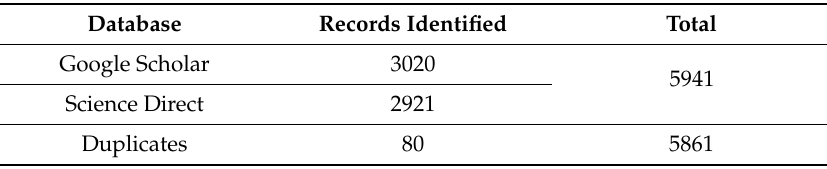
Table 1. Search strategy, studies between 2000 and